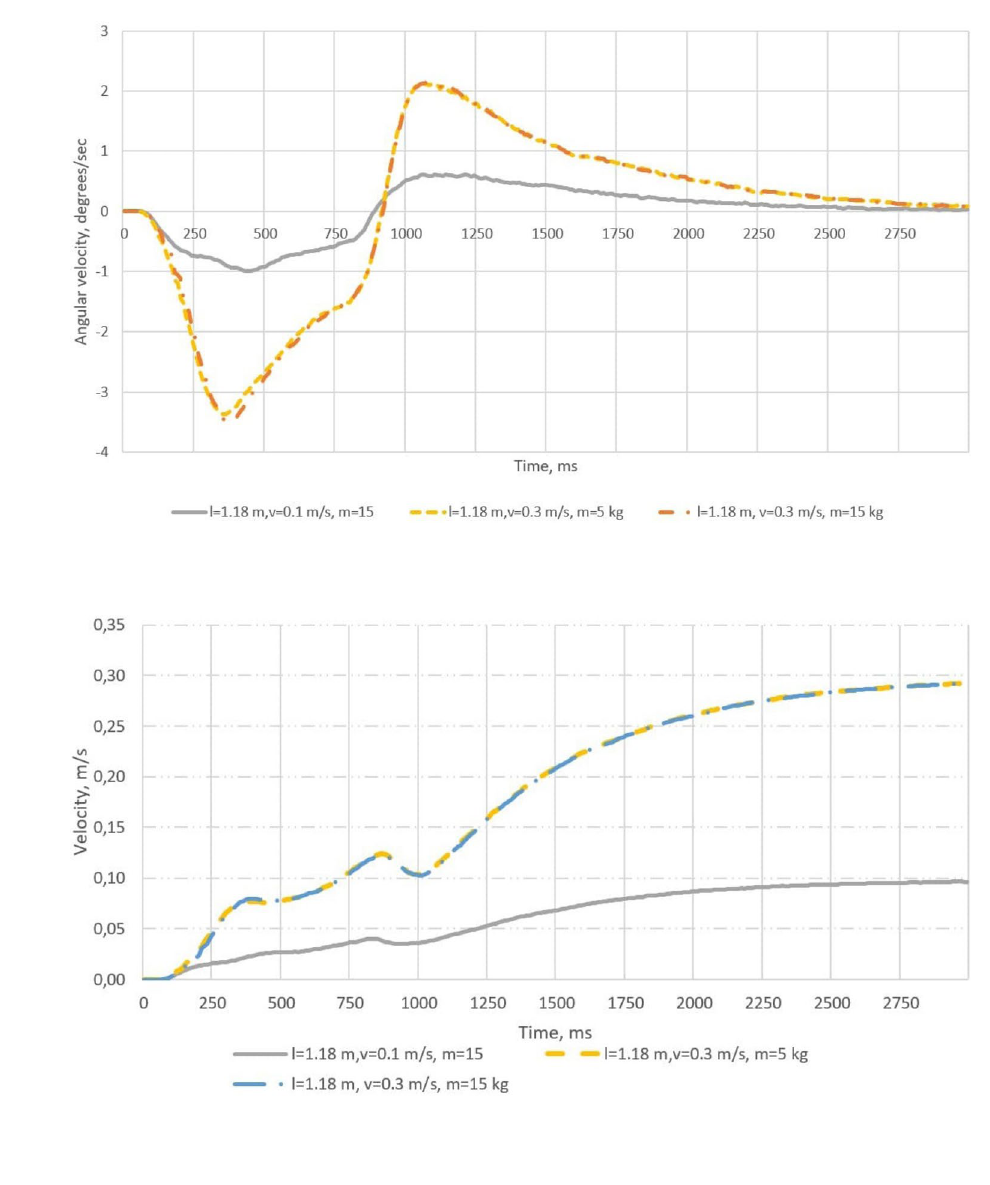
Fig. 9 Angular velocity of the